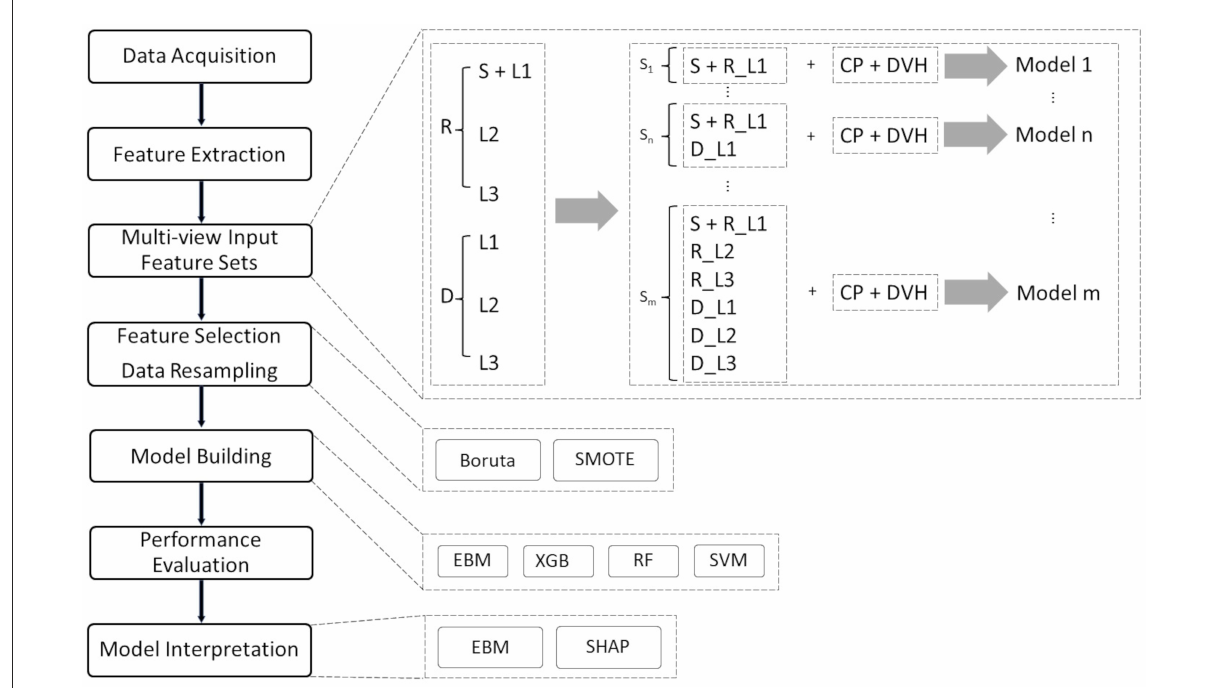
FIGURE1 Interpretable ML pipeline for pCR prediction. The entire procedure consists of eight distinct phases: data collection and cleaning, feature extraction, multi-view input feature categorization, feature selection, data resampling, model building, performance evaluation, and model interpretation. In the data cleaning session, cases with missing data and incomplete treatment (treatment interruptions) are removed from the